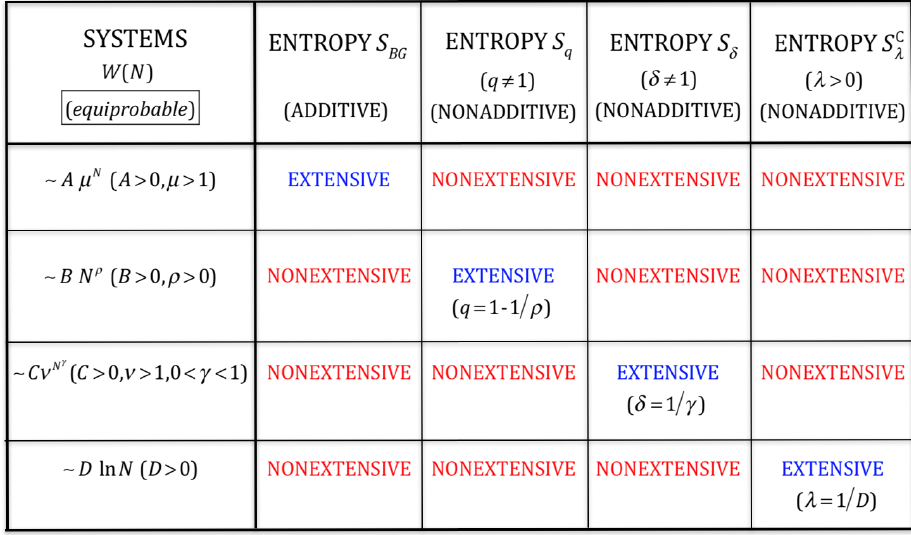
Figure 1. Typical behaviors of W ( N ) (number of nonzero-probability states of a system with N random variables) in the N → ∞ limit and entropic functionals which, under the assumption of equal probabilities for all states with nonzero probability, yield extensive entropies for specific values of the corresponding (nonadditive) entropic indices. Concerning the exponential class W ( N ) ∼ A µ N , S BG is not the unique entropy that yields entropic extensivity; the (additive) ) / ( 1 − q ) , also is extensive for all values of q . Anal- Renyi entropic functional, S R q ≡ k ( ln ∑ i p q i ogously, concerning the stretched-exponential class W ( N ) ∼ C ν N γ , the (nonadditive) entropic functional S δ is not unique. All the entropic families illustrated contain S BG as a particular case, ex- cepting the Curado entropy, S C , which is appropriate for the logarithmic class W ( N ) ∼ D ln N . λ In the limit N → ∞ , the inequalities µ N (cid:29) ν N γ (cid:29) N ρ (cid:29) ln N (cid:29) 1 are satisfied, hence ditive cases, the occupancy of the full phase space corresponds essentially to a zero Lebesgue measure, similarly to a whole class of (multi)fractals. If the equal-probabilities hypothesis is not satisfied, a specific analysis becomes necessary and the results might be different. Taken from